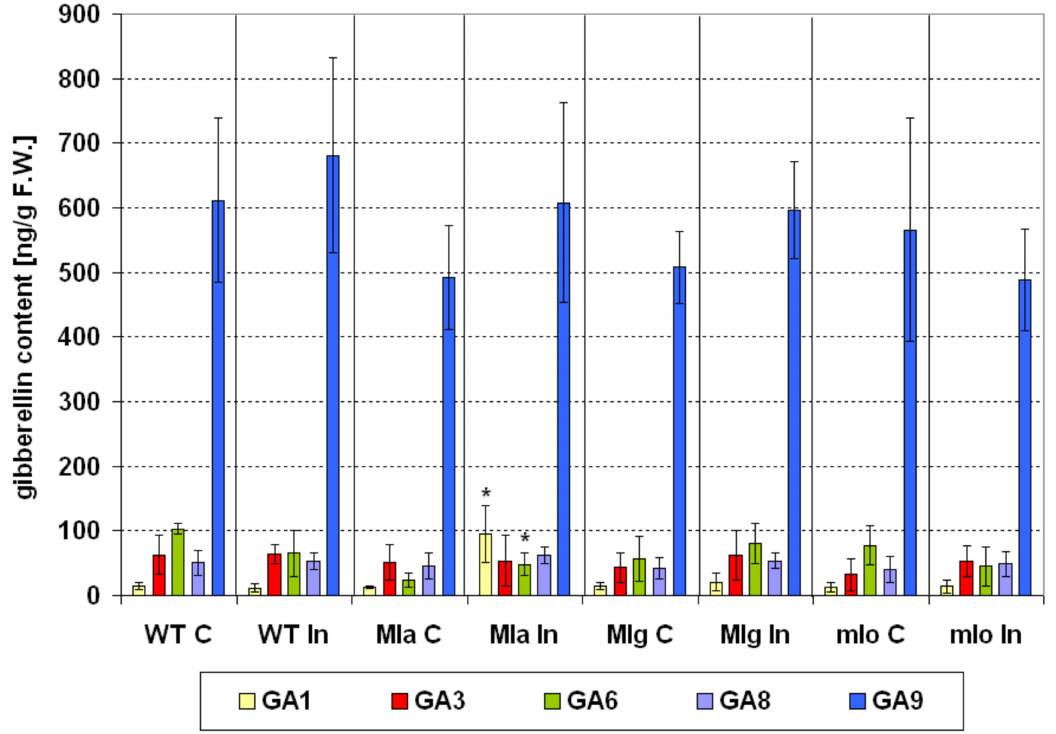
Figure 7. Changes in the contents of five gibberellins in leaves of the susceptible barley cultivar Ingrid and its three near-isogenic lines Mla, Mlg, and mlo at seven days following powdery mildew inoculation (7 dpi). Abbreviations: C, control; In, powdery mildew inoculated; WT, wild type cultivar Ingrid. Investigated hormones: gibberellin A 1 (GA1, active form), gibberellic acid (GA3, active form), gibberellin A 6 (GA6, active form), gibberellin A 8 (GA8, degradation form), and gibberellin A 9 (GA9, precursor form). Means of five independent repetitions ± SD are shown. The symbol * shows significant di ff erences between inoculated and control leaves ( p < 5%, Student t test) for each genotype (and for particular gibberellin)